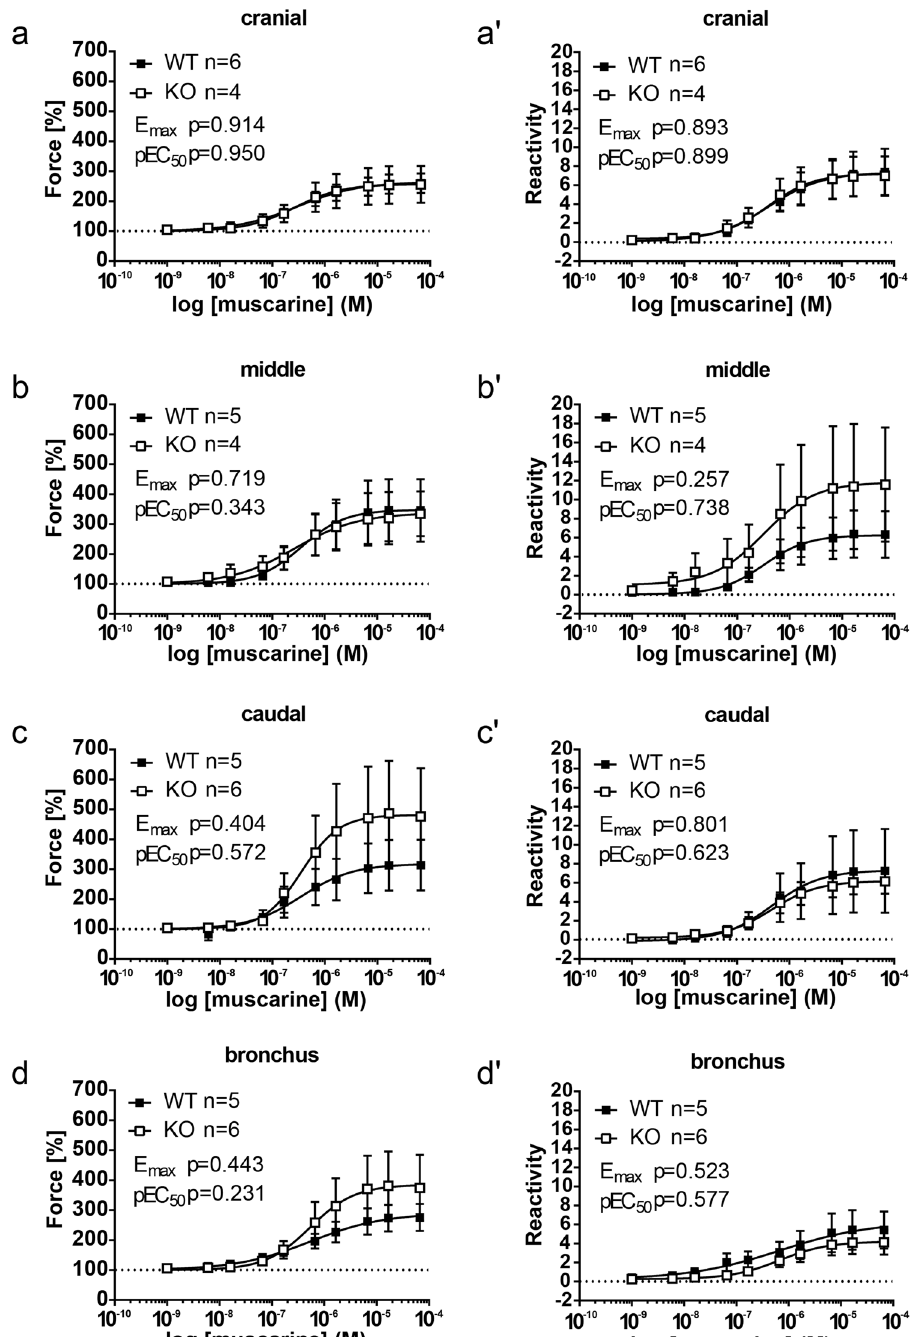
Figure 5. Comparison of force and reactivity in response to muscarine between cav-3 + / + (WT) and cav-3 − / − (KO) mice. For each individual experiment the maximal responses (E max ) and pEC 50 values for muscarine in force level ( a – d ) and airway reactivity (a’–d’) were estimated. All sigmoidal concentration-response curves were plotted according to the Hill equation. (a’–d’) The airway reactivity represents the constrictor response to muscarine compared to the corresponding KCl response. All data were analyzed with the Student’s unpaired t-test. Each point is shown as the mean number of animals (n) ± SEM. There is no difference between the cav- 3 − / − and the cav-3 + / + airway segments with regards to reactivity level and contraction